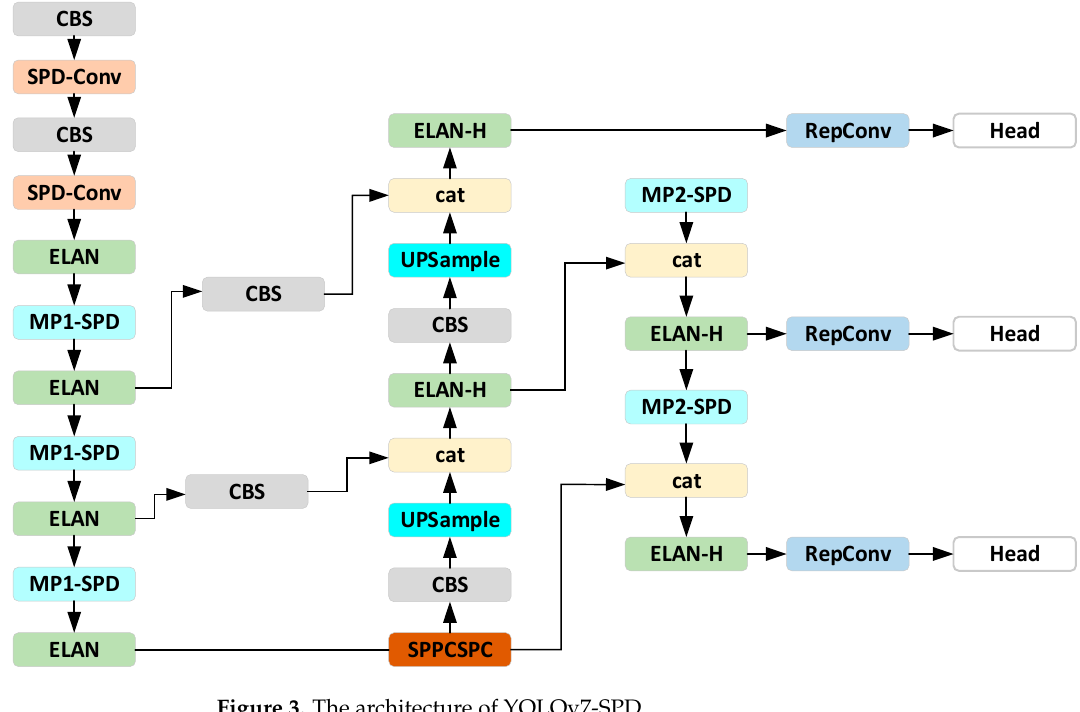
Figure 3. The architecture of YOLOv7-SPD.